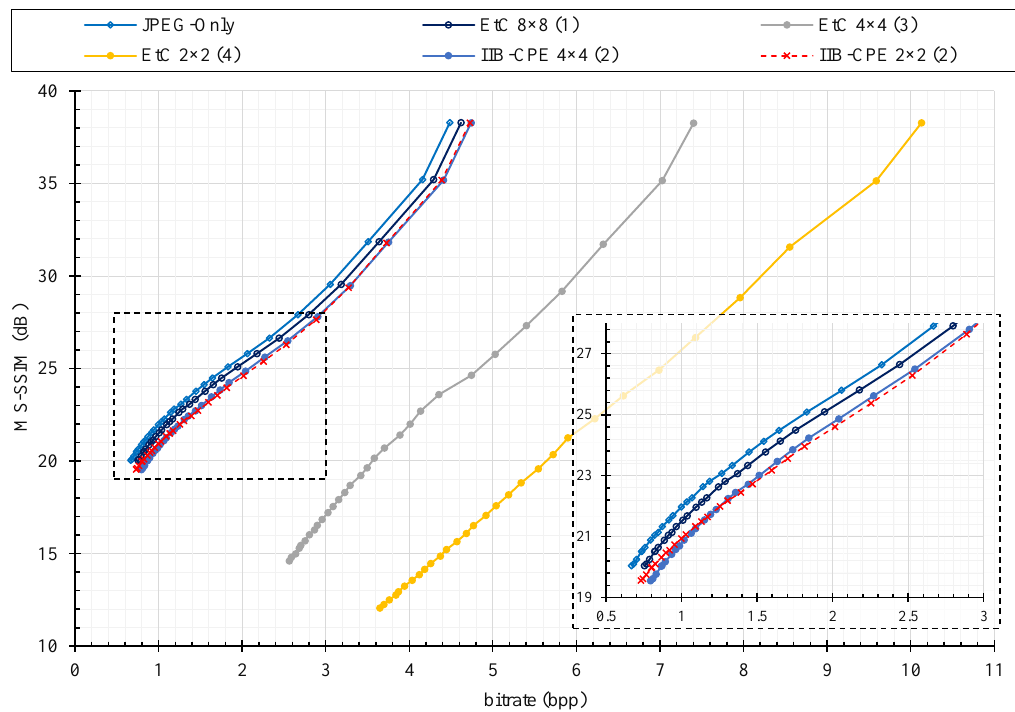
Figure 8. The JPEG compression performance on different perceptual encryption methods in terms of rate distortion (RD) curves with respect to MS–SSIM (dB) on Shenzhen grayscale images dataset. The number enclosed in parentheses at the end of each series name shows its performance rank. The overlapping regions in the graph are zoomed in and shown in the bottom right corner.